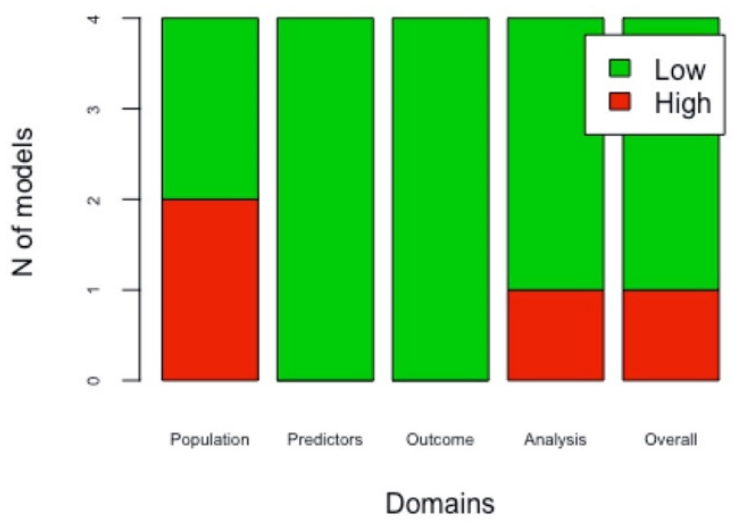
Figure 3. Risk of bias of models’ external validations: For each of the four externally validated prognostic models included in this systematic review, four domains of bias (population, predictors, outcomes, analysis) were assessed as “high” or “low”. In this way, the overall risk of bias of each article was